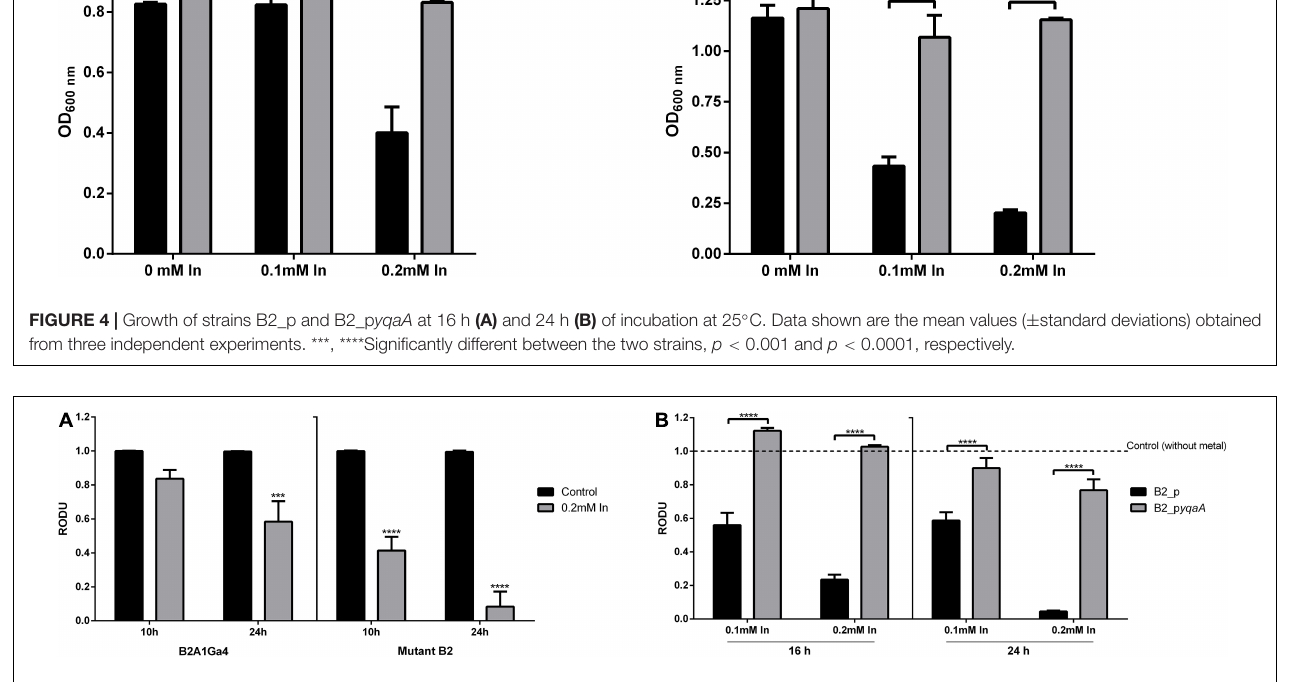
FIGURE 5 | Metabolic cellular activity of the studied strains. MTT assays of strains B2A1Ga4 and B2 (A) MTT assays of strains B2_p and B2_p yqaA (B) . Data shown are the mean values ( ± standard deviations) obtained from three independent experiments. ***, ****Significantly different from the value of Control (without metal), p < 0.001 and p < 0.0001, respectively. Relative optical density units (RODU) means the ratio between the OD 550 (absorbance at 550 nm) of the sample (test) and the OD 550 of the control